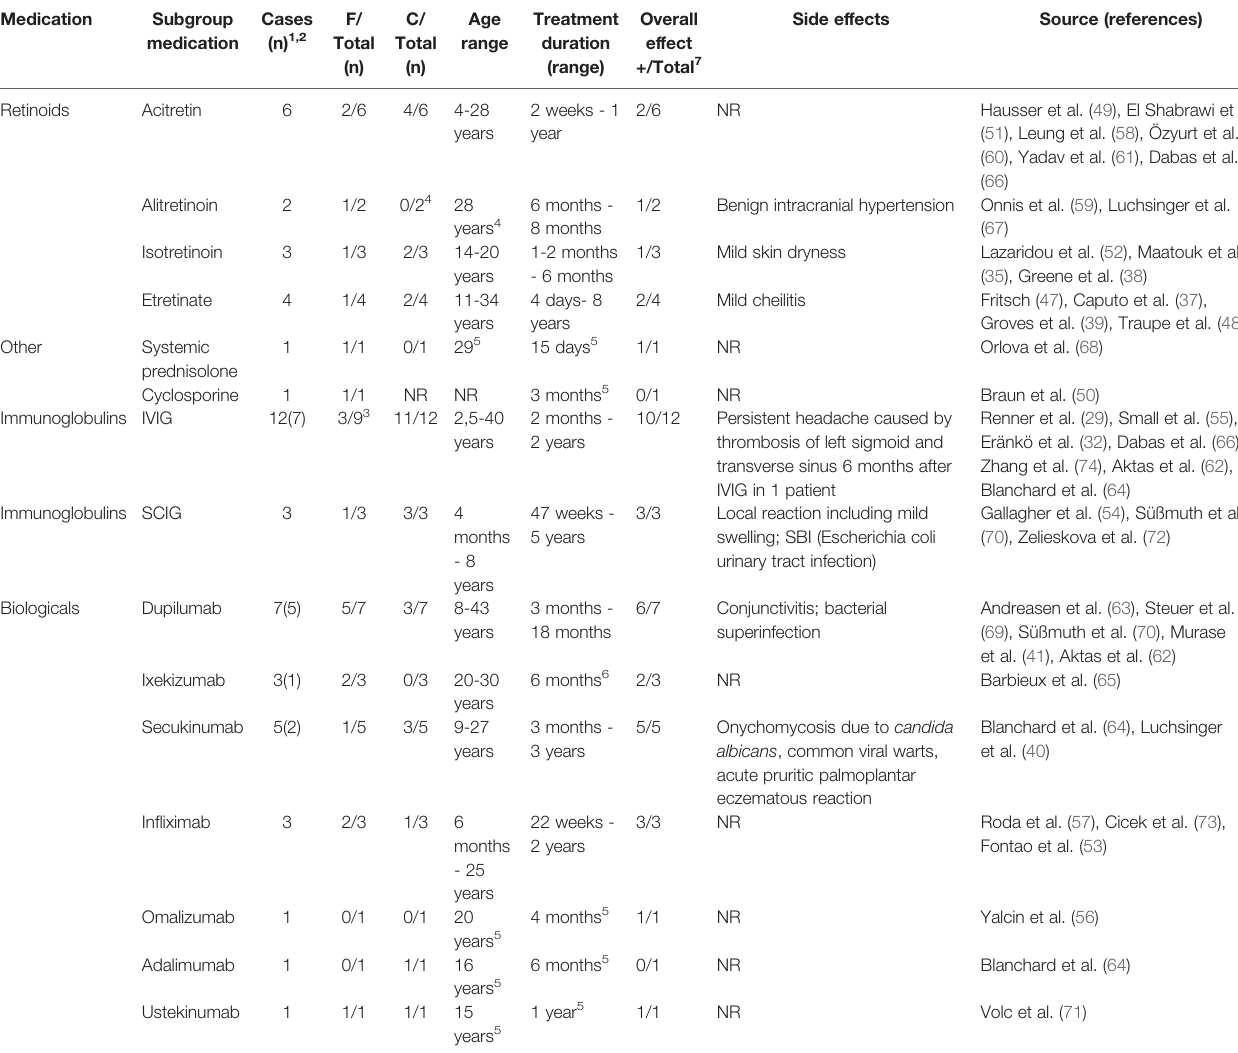
TABLE 2 | Overview of systemic